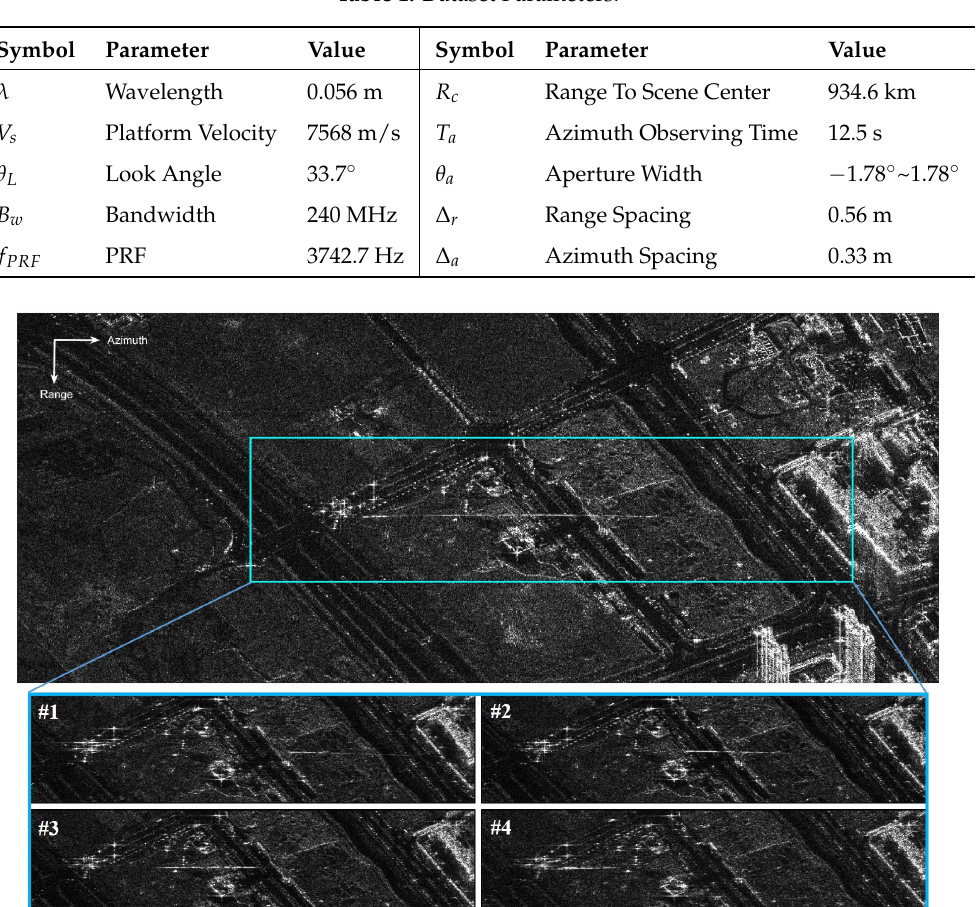
Table 1. Dataset Parameters.